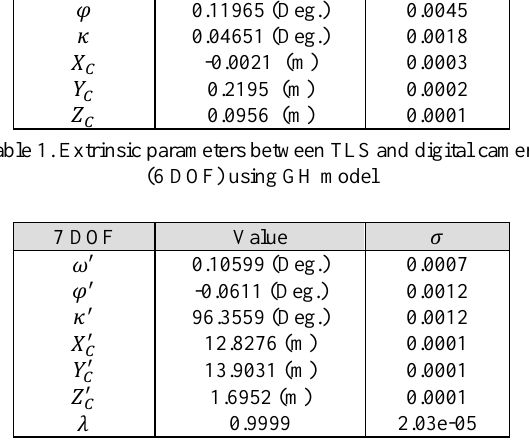
Table 2. Extrinsic parameters between TLS and LT (7 DOF)